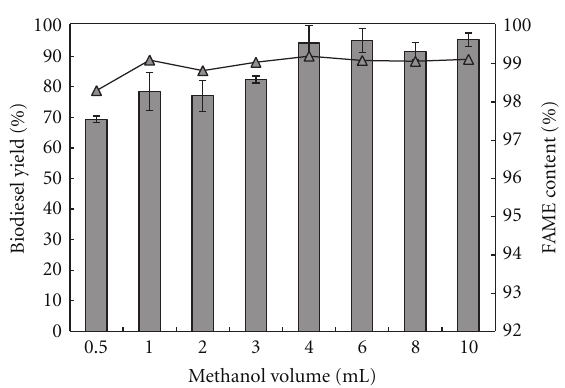
Figure 4: E ff ects of methanol volume on the biodiesel yield ( (cid:4) ) and FAME content ( (cid:2) ) by in situ transesterification of C. pyrenoidosa . Reaction condition: 1g algal powder with 6mL n -hexane and 0.5 M sulfuric acid at 90 ◦ C. Methanol volume: 0.5, 1, 2, 3, 4, 6, 8, and 10mL. Error bars = mean ± standard